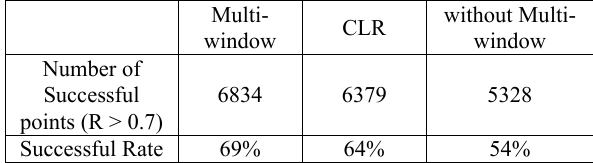
Table 3. Results of Image Matching